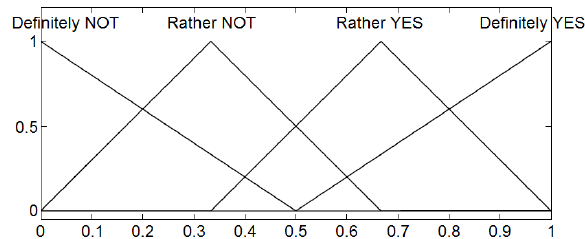
Figure 9: Membership function for the output variable y – IRF(Uph) , polygonal functions (piecewise